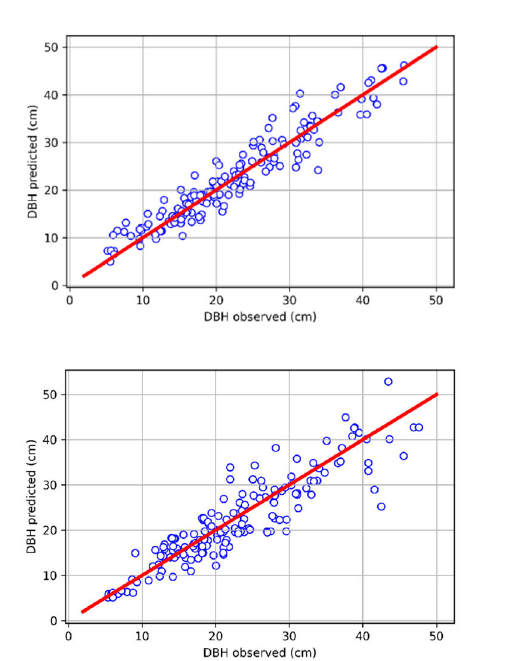
Figure 3 . Plots of the observed/predicted values of DBH for a test dataset case (157 Aleppo pine trees not used for training) given by two multivariate allometric models (DBH = Φ(H, CD)). Top: Linear Regression (R 2 = 89.02%). Bottom: Decision Tree Regression (R 2 = 79.86%). Red line refers to 1:1